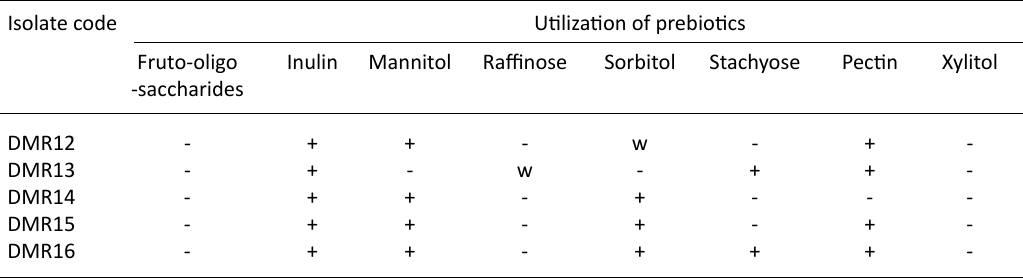
Table 2. Utilization of prebiotic components by LAB isolates having AAI activity Isolate